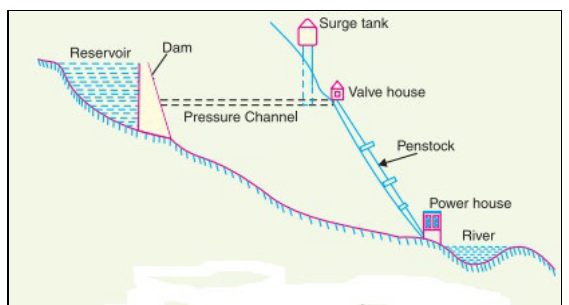
Figure 1. A typical layout of a hydropower plant (Source: Electrical Engineering Info., India)